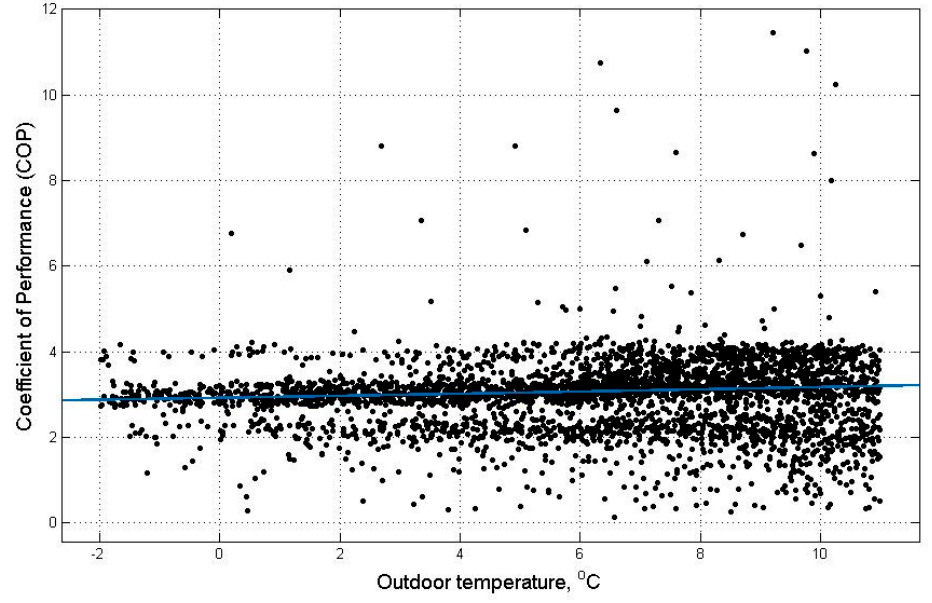
Figure 2. Coefficient of Performance (COP) versus outdoor temperature for a heat pump operating over a one-year period.